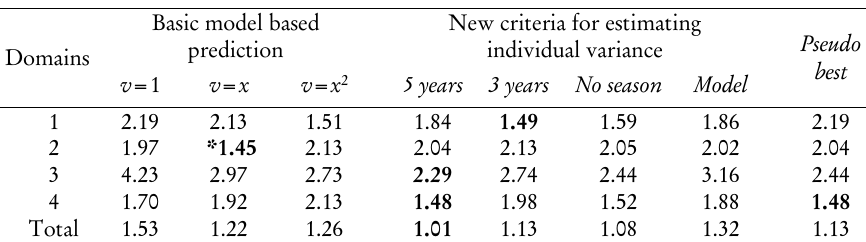
Comparison among MAPEs obtained through the use of GREG estimation and different criteria for model unit variance estimation Mean of 4 quarters – Real data referred to 2010 New criteria for Domains